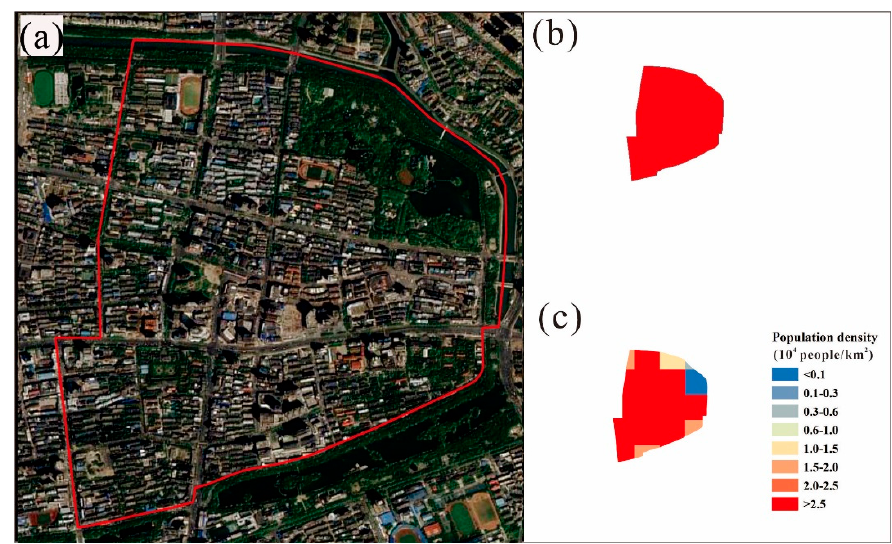
Figure 8. Comparison of ( a ) the high-resolution image, ( b ) the population density at the township scale, and ( c ) that at the 500 m scale in Xiaoyaojin Township as the high-density areas. Located at the junction of the main city of Hefei and Feixi County, Shangpai covers an area of 121 km 2 , with a population density of 2228.29 people/km 2 . From the high-reso- lution image (Figure 9a), the central area of Shangpai Township is located in the northern part, and several dwelling units are sprinkled in the south-eastern area. Other areas are mainly forests or croplands. The population density of the Shangpai town, displayed in Figure 9b, does not consider the internal population distribution differences. The yellow pixels shown in Figure 9c correspond to the building area in Figure 9a, which represents the area where the population is concentrated.